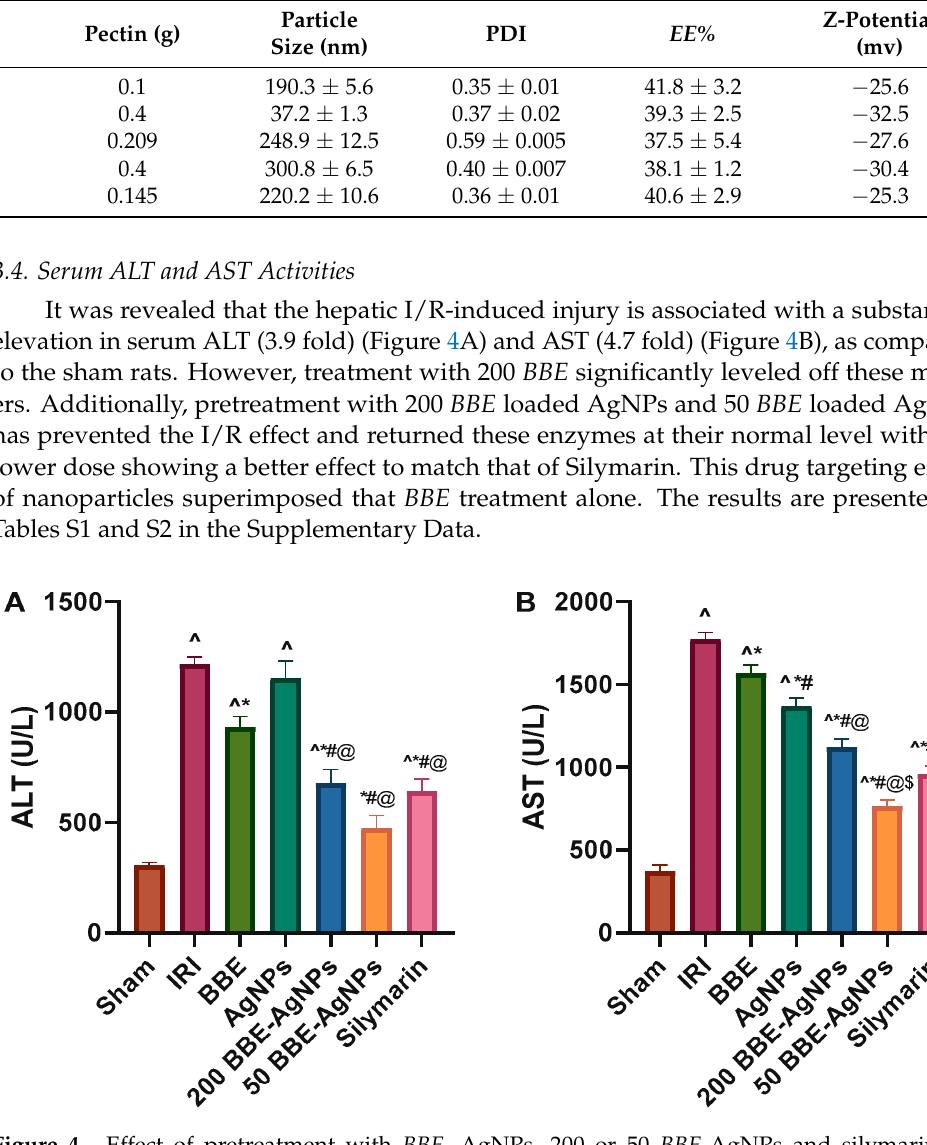
Figure 4. Effect of pretreatment with BBE , AgNPs, 200 or 50 BBE -AgNPs and silymarin on serum ( A ) ALT and ( B ) AST level in hepatic I/R injured rats. Values are presented as means of 6 animals ± SEM. Data were analyzed using one-way ANOVA followed by Tukey’s Multi- ple Comparisons Test; p < 0.05. As compared with (ˆ) Sham, (*) IRI, (#) BBE , (@) AgNPs and ($) 200 BBE -AgNPs. ALT, alanine transaminase; AST, aspartate transaminase; BBE , Blackberry Ex- tract; IRI, ischemia/reperfusion injury; AgNPs, Silver Nanoparticles; BBE -AgNPs, Blackberry loaded Silver